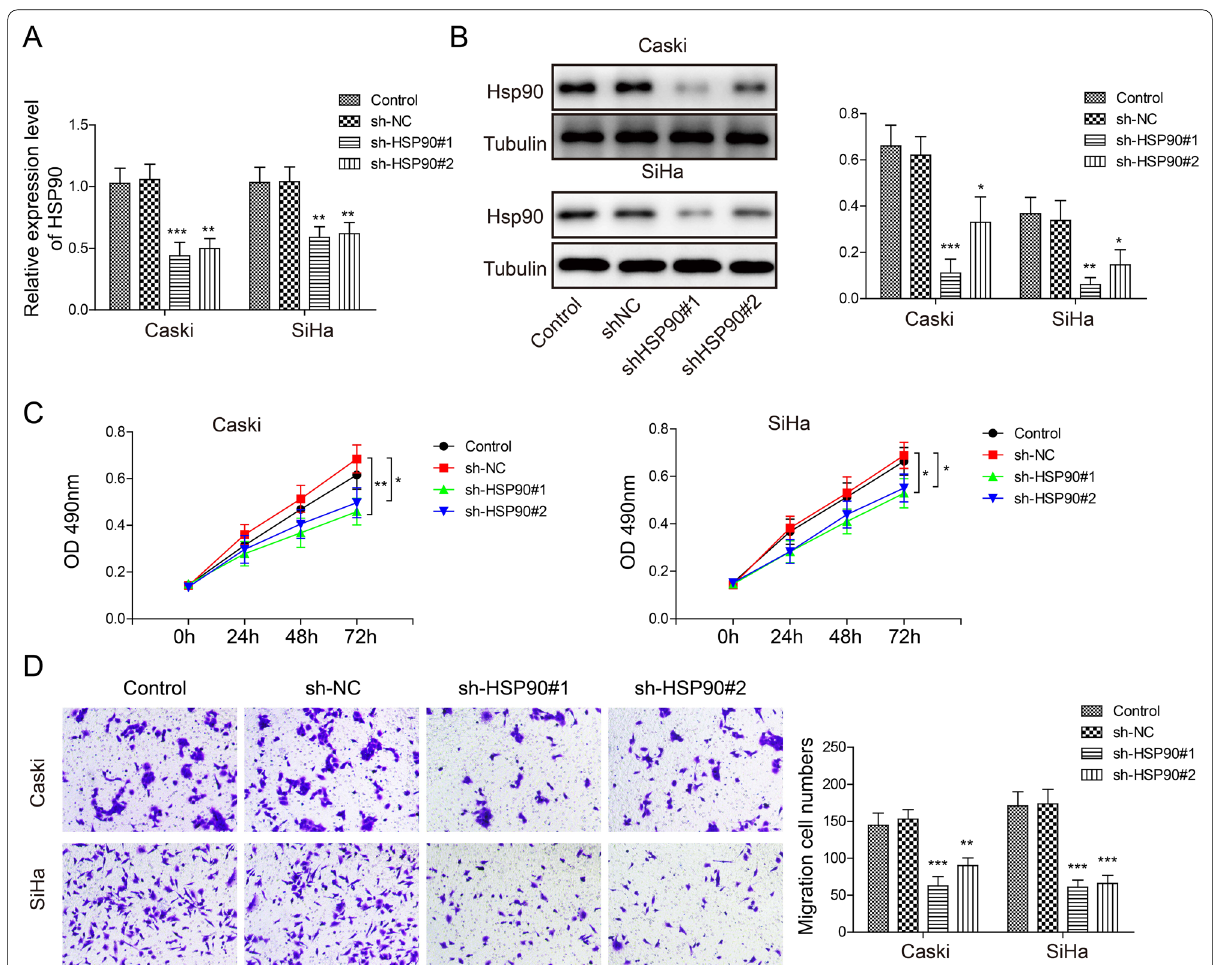
Fig. 2 Hsp90 knockdown inhibited HPV16 + cervical cancer cell proliferation and migration. In Caski and SiHa cell culture, A Hsp90 gene expression in control, shNC, sh‑Hsp90#1 and sh‑Hsp90#2 groups. B Western blotting image and analysis of Hsp90 expression in control, shNC, sh‑Hsp90 groups. C MTT assay evaluating cell proliferation in control, shNC, sh‑Hsp90#1 and sh‑Hsp90#2 groups. D transwell assay evaluating cell migration in control, shNC, sh‑Hsp90#1 and sh‑Hsp90#2 groups. N 3 in each group. * p < 0.05, ** p < 0.01 or *** p < =